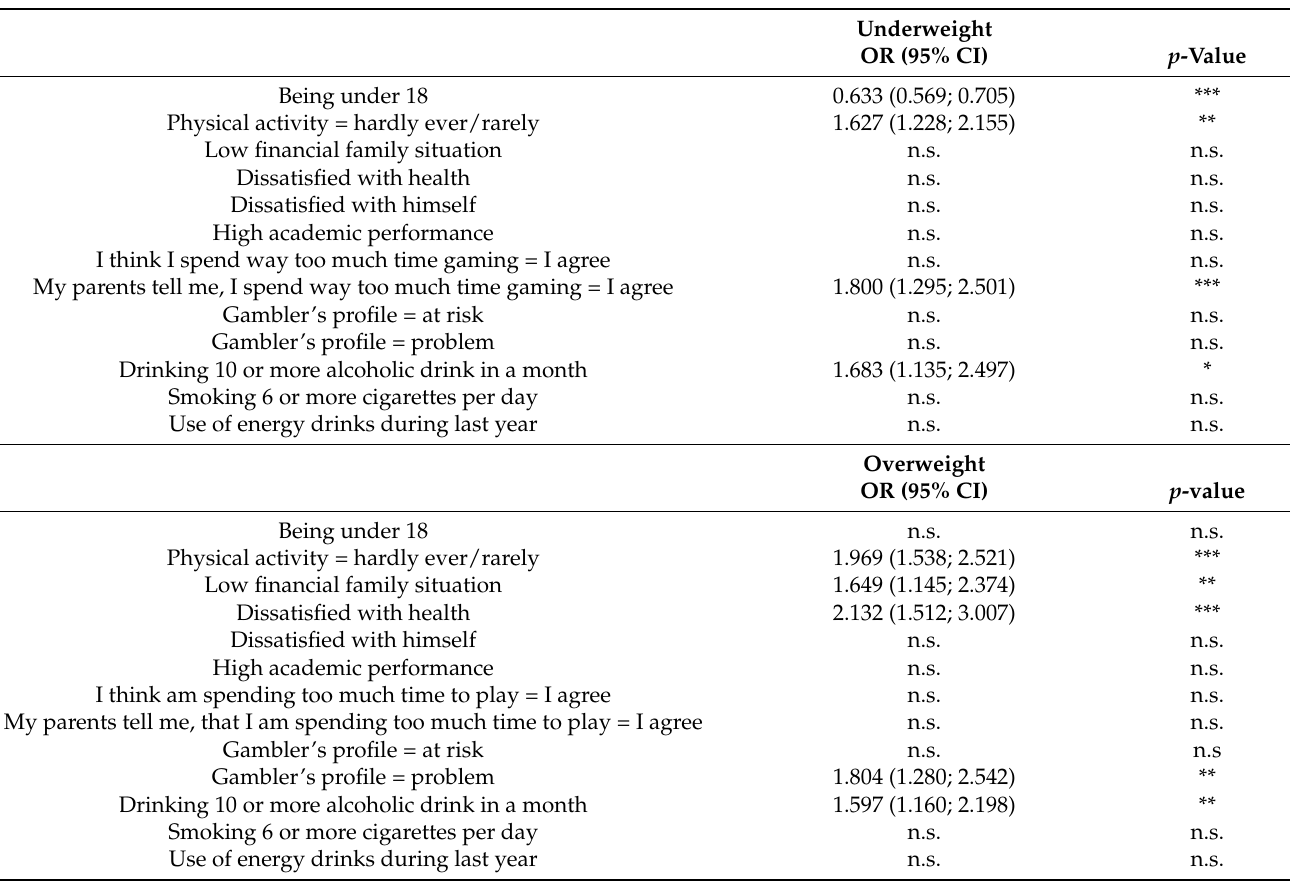
Table 3. Multinomial logistic regression model: association of extreme categories of BMI with possible risk